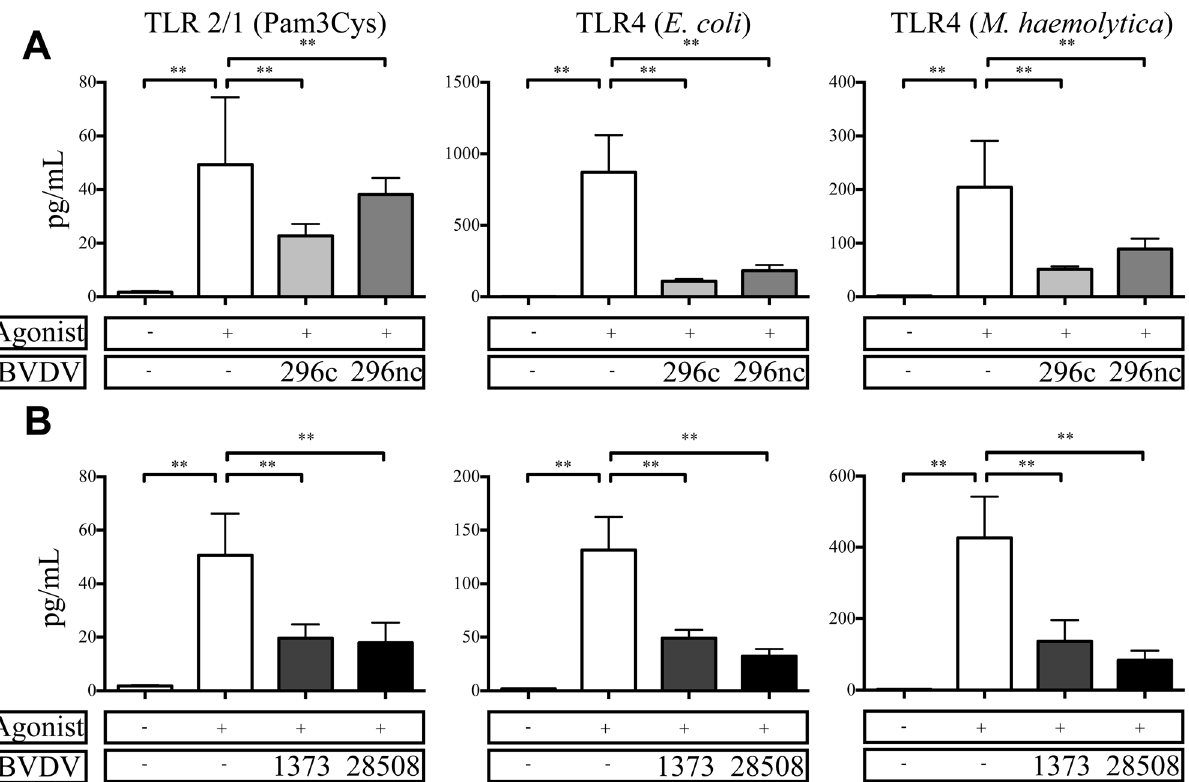
Fig 4. TNF α protein secretion from BVDV2 infected monocyte derived macrophages after stimulation with bacterial TLR agonists. MDM Φ s were differentiated in 96 well plates for 7 days and inoculated with BVDV2 strains with an MOI of 1 for 48 h prior to stimulation with Pam3Cys [5 μ g/mL], M . haemolytica LPS [10 μ g/mL], or E . coli (055:B5) LPS [1 μ g/mL]. Cell supernatants were analyzed for TNF α protein concentration 24 h after TLR stimulation and measured by Searchlight Array platform. Data from infection with cytopathic or noncytopathic strains are in the top panel (A) and from high or low virulence strains indicated in the lower panel (B). Bars represent the mean value ± SEM from four different experiments from 9 total donor cattle. ** P < 0.001 compared to uninfected, TLR stimulated cells.